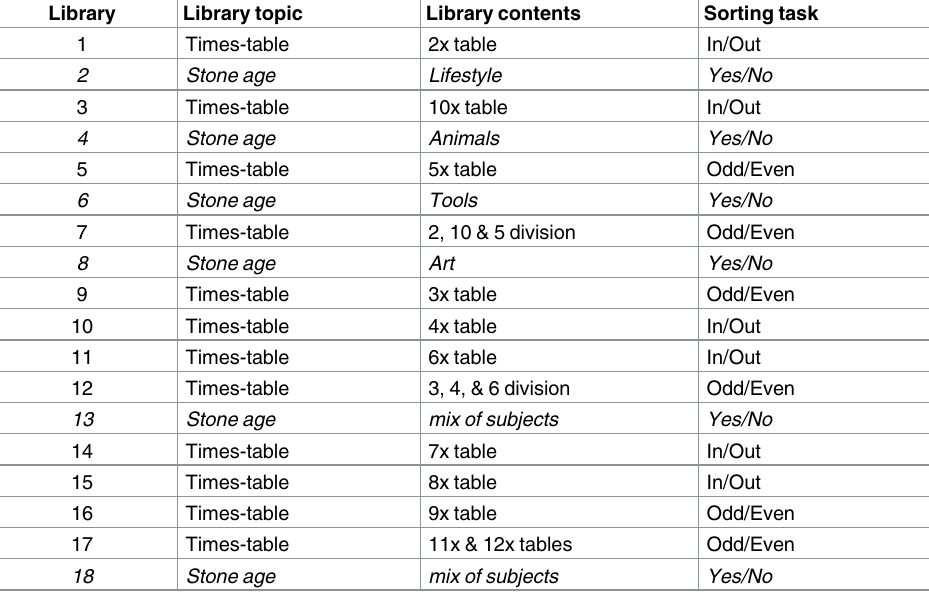
Table 1. Image libraries used for the sorting tasks. Shownare the type of sorting task for each library, and the categories used for the sorting itself. There were 14 images per stone age library, and 12 images per times-tablelibrary. Stone age libraries are in italics: the fifth and sixth of these were combinations of images from the first four stone-age libraries